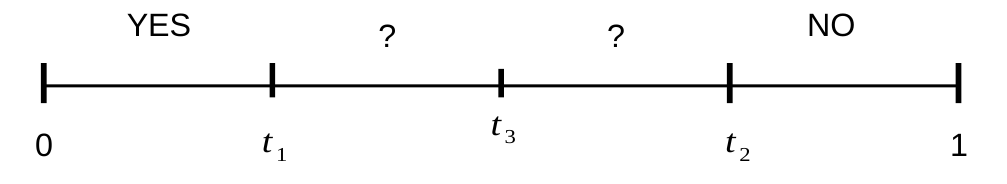
Figure 1. Face identification